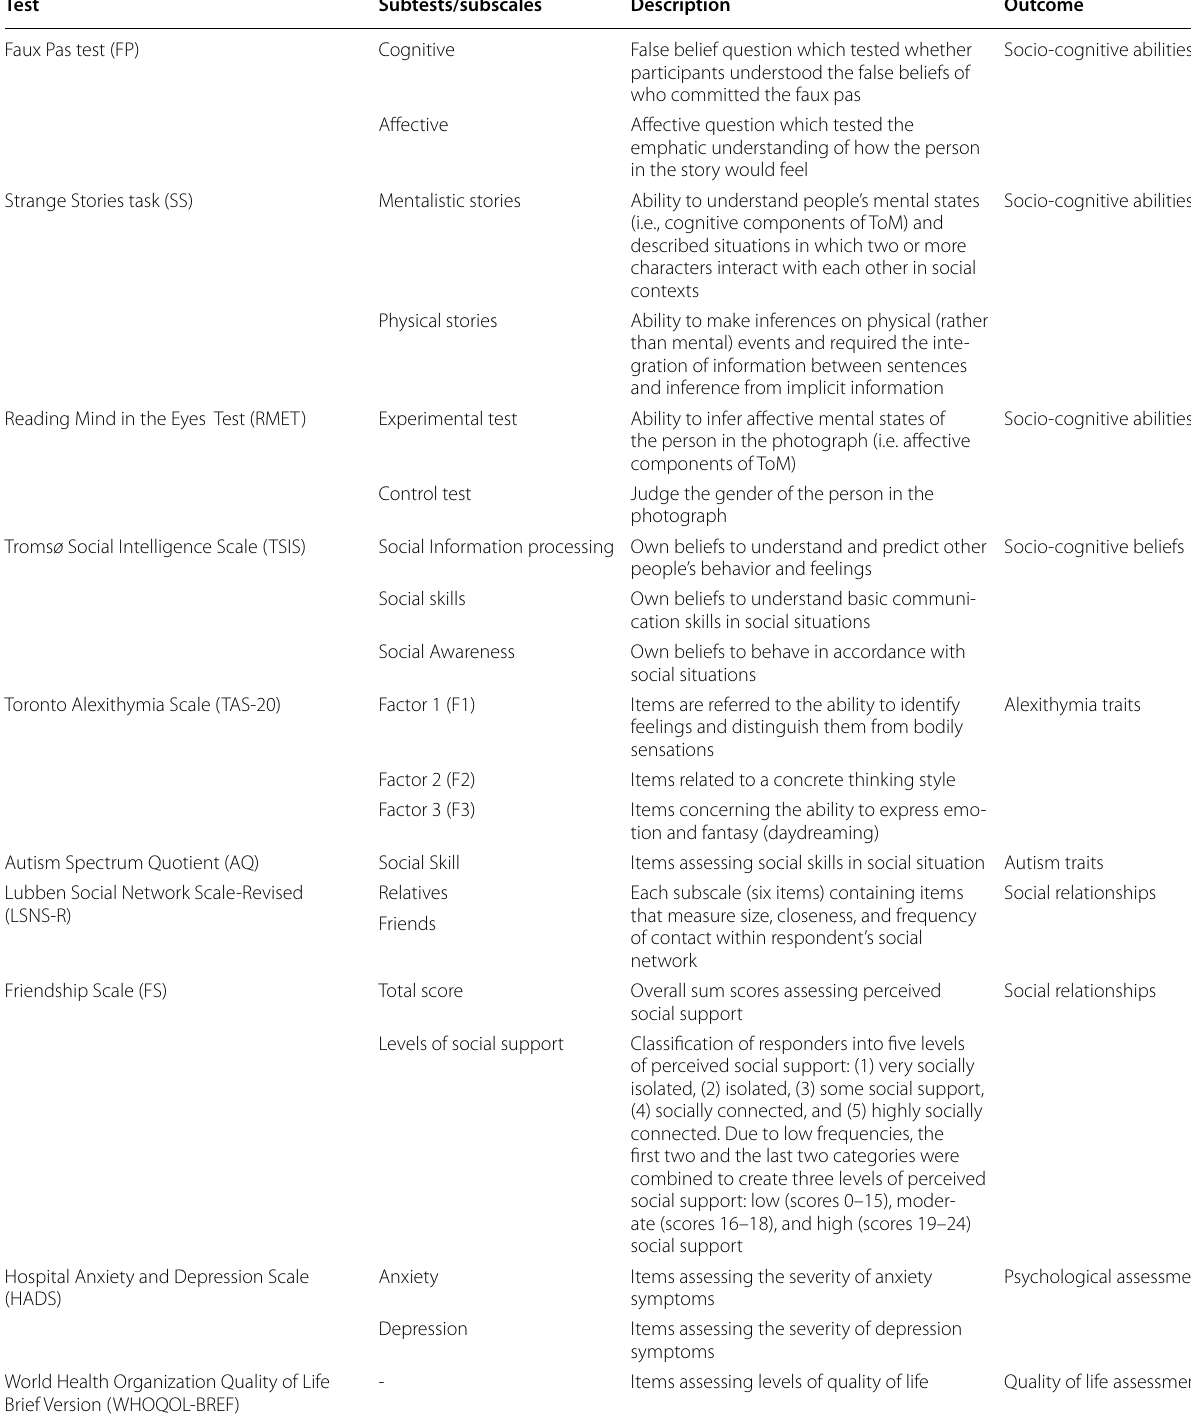
Table 2 Description of tests used in the